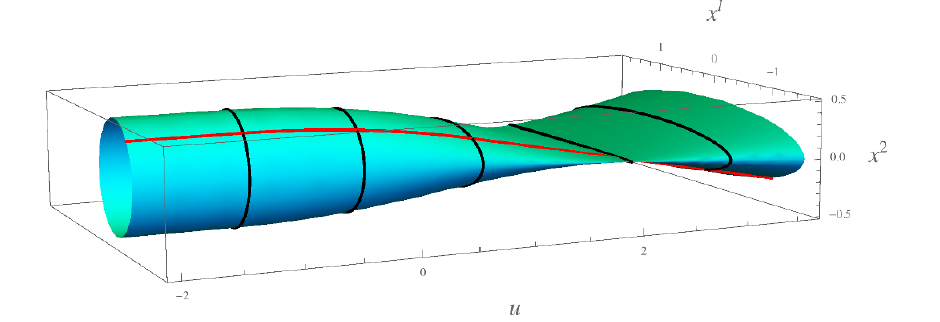
Figure 7 . Illustration of the evolution of the Tissot ring of geodesics through the passage of an extended plane-wave burst. The red curve shows a single geodesic described by ( x 1 ; x 2 ) as in (cid:12)gure 6. The combination of expansion ^ (cid:18) and shear ^ (cid:27) + causes the Tissot circle to deform to an ellipse, degenerate to a line, then form an expanding ellipse in the far memory region following the gravitational wave burst. (Note that the u axis has been rescaled by a factor 5 compared to the previous (cid:12)gures for